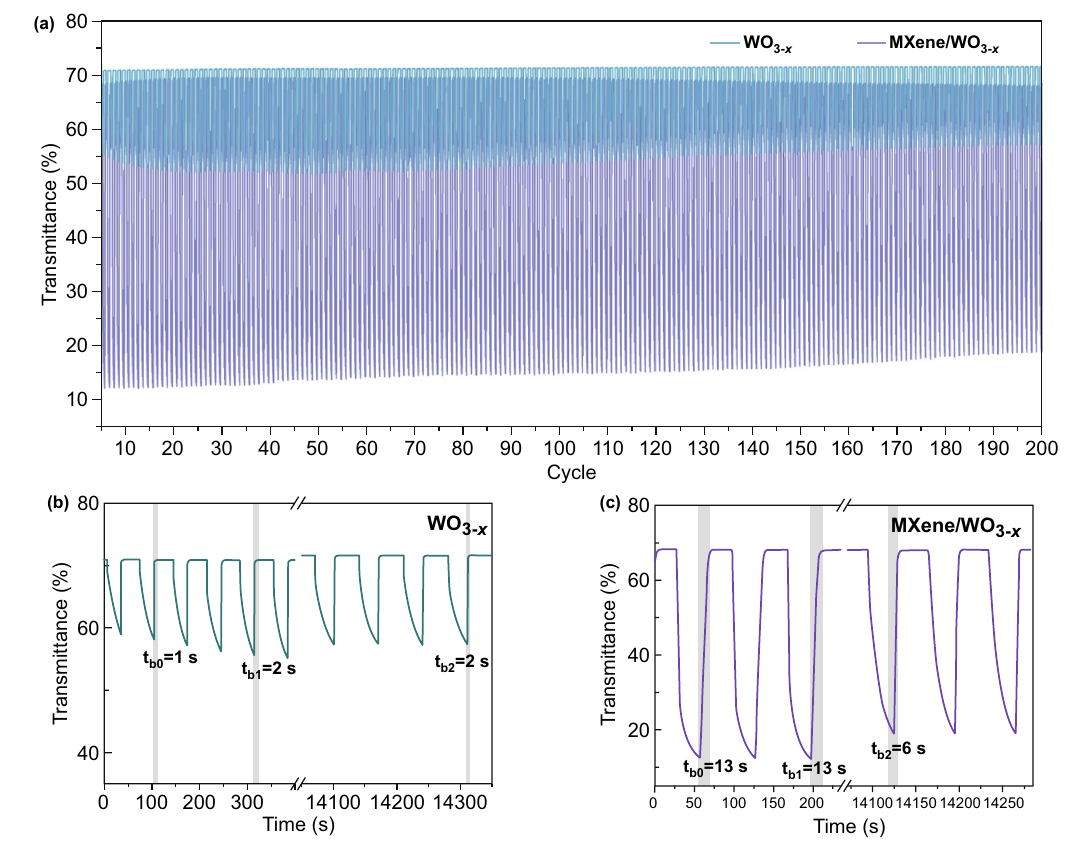
Fig. 3 a Cyclic stability of pure WO 3− x and MXene/WO 3− x electrochromic devices. b Amplified in situ transmittance curve of the pure WO 3− x device. c Amplified in-situ transmittance curve of the MXene/WO 3− x